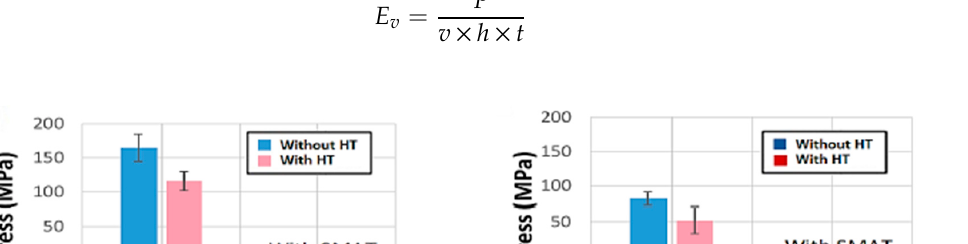
( b ) Figure 13. Transmission Electron Microscopy (TEM) image of ( a ) EBM as-built specimens, and ( b ) Laser